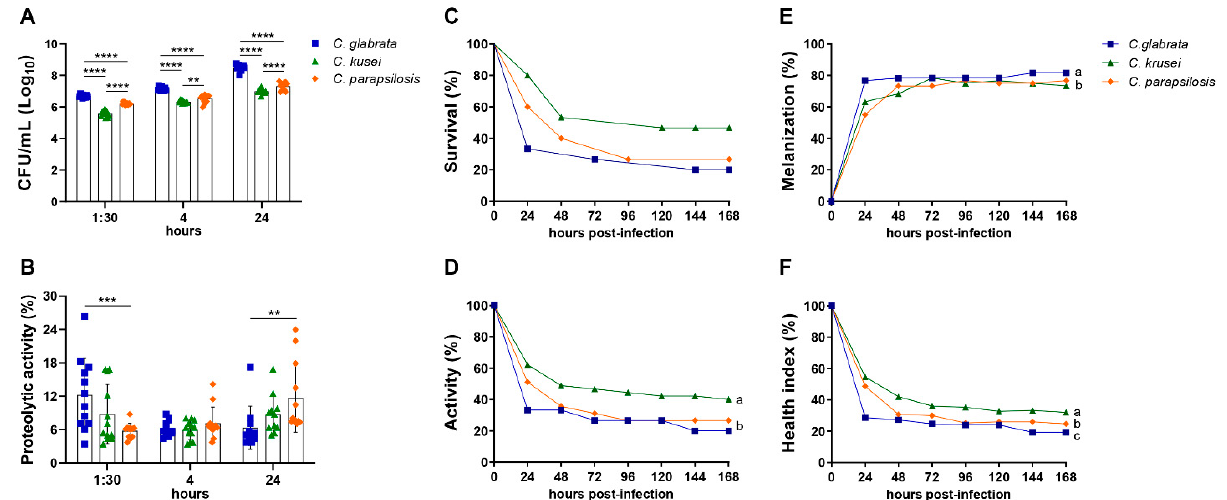
Figure 2. Virulence evaluation of non- albicans Candida species by using biofilm formation assay and Galleria mellonella model. Biofilm formation represented by colony-forming units (CFU/mL) ( A ) and the proteolytic activity ( B ) were analyzed at 1:30, 4, and 24 h after in vitro-inoculation of 1 × 10 7 cells/mL of Candida glabrata , C. krusei , or C. parapsilosis . Larvae of Galleria mellonella were infected with 1 × 10 9 cells/mL of each strain and evaluated every day for 7 days to determine the survival curve ( C ). The parameters of larval activity ( D ) and melanization ( E ) were also calculated. These data were used to determine the healthy index ( F ). The results are expressed as mean ± SD from three independent experiments (n = 12/group) and ** p < 0.01, *** p < 0.001, and **** p < 0.0001 ( A , B ). The survival curves were evaluated using the Kaplan–Meier, an product limit estimate, in two independent experiments (n = 15/group) ( C ). The results are expressed as mean from two independent experiments (n = 15/group), and different letters indicate p < 0.05 ( D – F ).